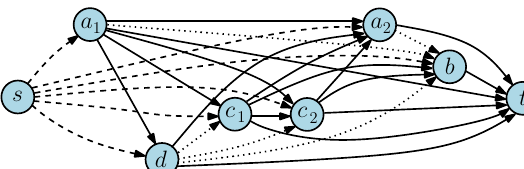
Figure 3 Minimum cost flow network for S = a d c c a b assuming L = d - a - c - b